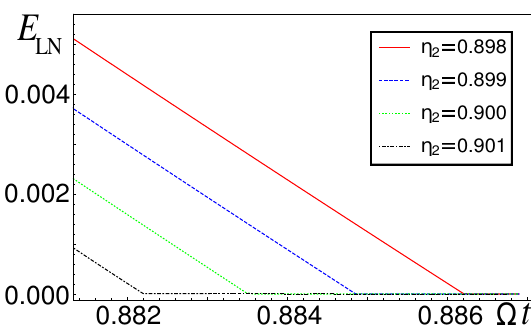
Figure 1: Time dependence of the entanglement between the two kinds of untrapped impurities . Entanglement, as evaluated using Eq. (75), is observed at the long but not infinite time limit, for the case of untrapped impurities of potassium K in a bath of particles of Rubidium Rb, at the low temperature limit. The initial variances of position and velocity for the two particles, as well as their covariances, are assumed ( 0 ) 〉 = 〈 ˙ x 2 ( 0 ) 〉 = (cid:10) ˙ x ( 0 ) x ( 0 ) (cid:11) = (cid:10) ˙ x ( 0 ) ˙ x ( 0 ) (cid:11) = 0 for j ∈ { 1,2 } , to be 0, i.e. 〈 x 2 j q j q j j however the qualitative behavior was the same for other initial conditions as well, namely for setting all quantities equal to a finite value (in particular equal to 1). Entanglement, decreases to zero as time passes. It is studied for a number of dif- ferent coupling constants η of the second impurity. The rest of the parameters are 2 Ω = 2 π · 500 Hz , η = 1, g = 3 · 10 − 37 J · m and n = 7 ( µ m ) − 1 . It is observed that 1 B 0 increasing η decreases both the value of the entanglement and the time at which it 2 reaches